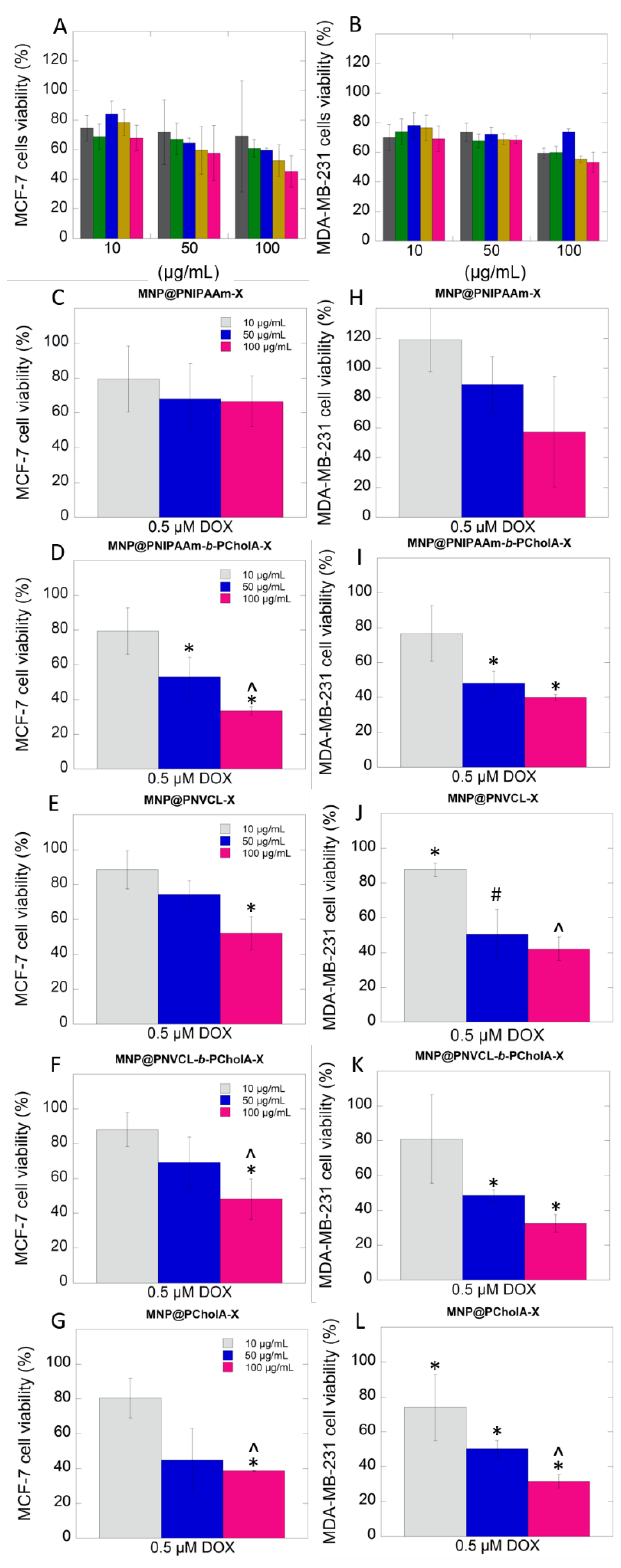
Figure 6. Toxic effect of the polymer – iron oxide hybrids against estrogen-dependent and estrogen-independent breast cancer cells. Viability of estrogen-dependent ( A ) and estrogen-independent ( B ) breast cancer cells in the presence of the polymer – iron oxide hybrids. Cytotoxic effect of the mixtures of DOX and polymer – iron oxide hybrids against estrogen-dependent ( C – G ) and estrogen-independent ( H – L ) breast cancer cells. Statistical significance for the tested hybrid vs. control was